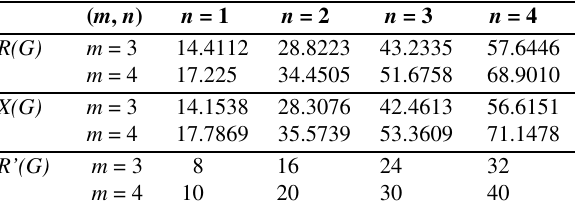
Table 1. Some values of Randi}, Sum-connectivity and Modify Randi} Indices of TiO ( m,n ) nanotubes corresponding to the chan- 2 ge in m and n